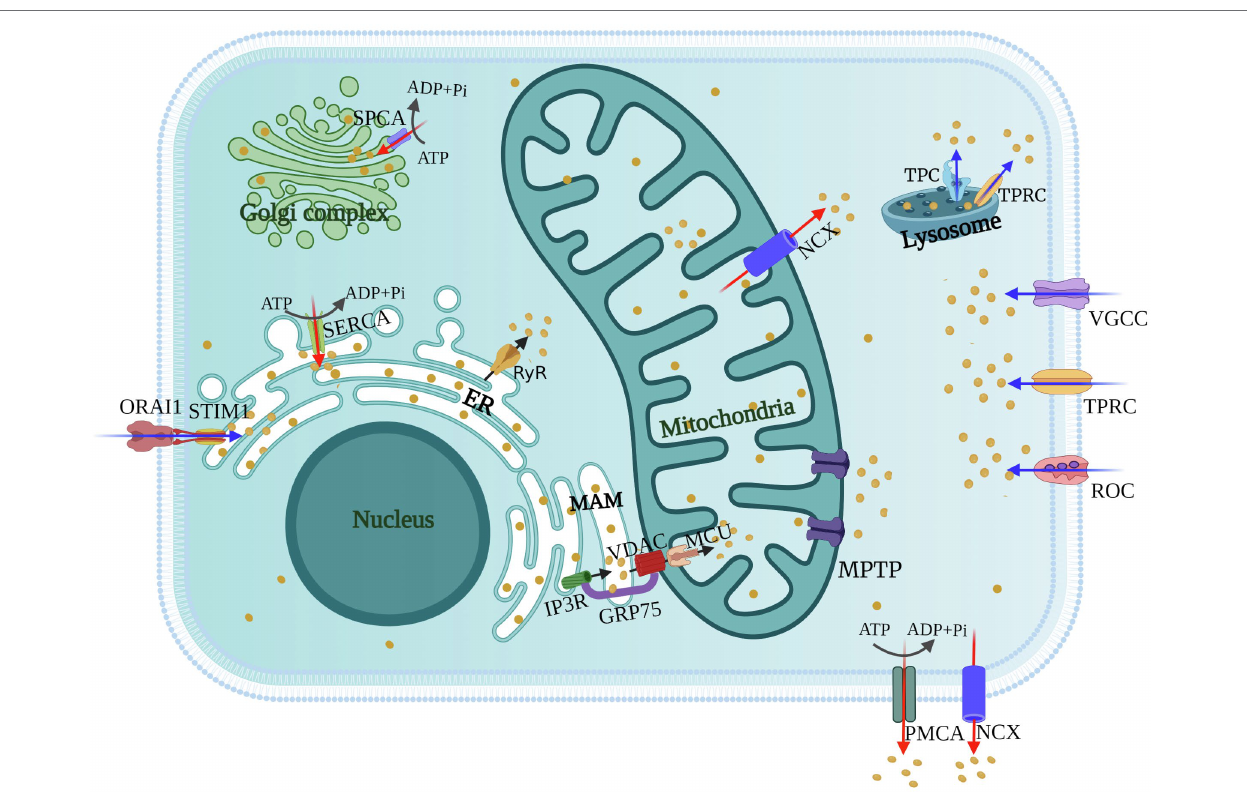
FIGURE 1 | Schematics of cellular calcium channels and pumps. Calcium channels [voltage-gated calcium channels (VGCCs), receptor-operated calcium channels (ROCs), store-operated Ca 2+ channels (SOCs), and transient receptor potential (TRP) channels] mediate the entry of Ca 2+ from the extracellular environment or the release of Ca 2+ from the Lysosome (blue arrows). The inositol trisphosphate receptors (IP 3 Rs) and ryanodine receptors (RyRs) on the ER or Golgi regulate the release of Ca 2+ from intracellular stores (black arrows). Ca 2+ is transported between the ER and mitochondria via mitochondrial-associated membranes (MAMs), and mitochondrial uptake of Ca 2+ is through voltage-dependent anion channels (VDACs) and mitochondrial calcium uniporters (MCUs). Calcium pumps [SR Ca 2+ -ATPase (SERCA), secretory pathway Ca 2+ -ATPase (SPCA), and plasma membrane Ca 2+ -ATPase (PMCA)] and the Na + /Ca 2+ exchanger (NCX) transport Ca 2+ from the cytosol to extracellular environment or intracellular stores (red